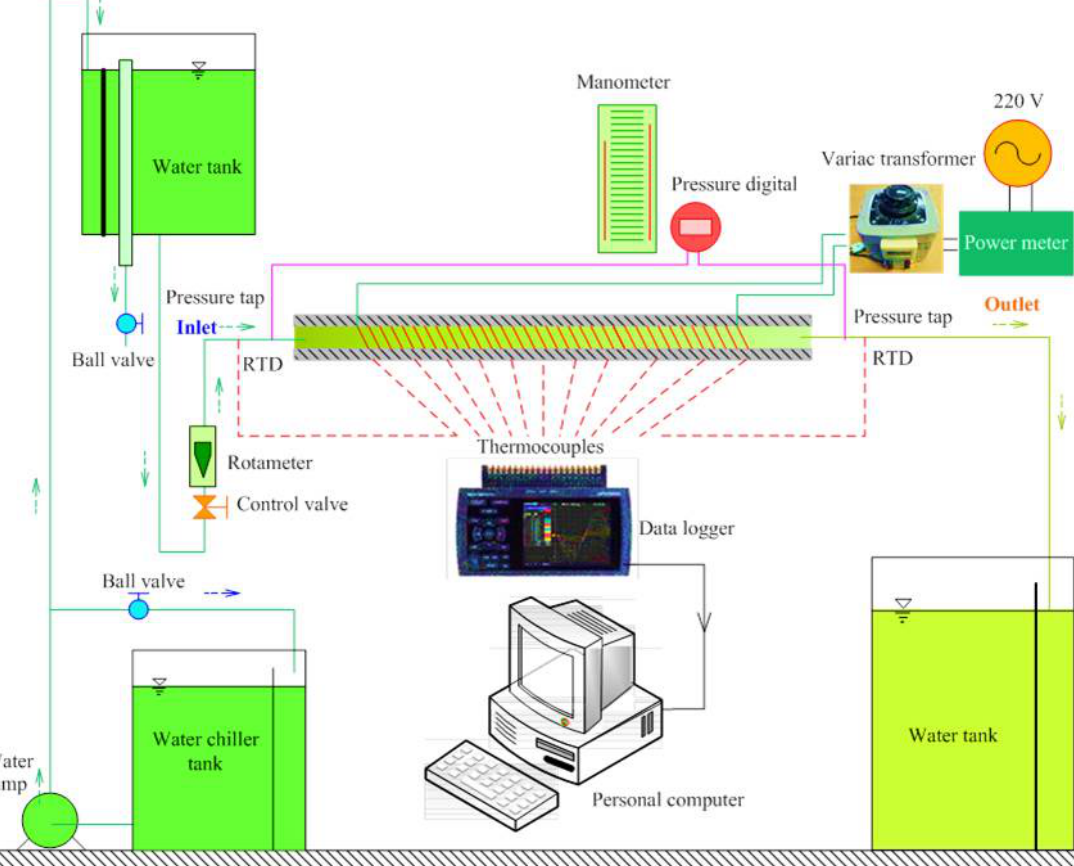
Figure 2: Experimental heat transfer